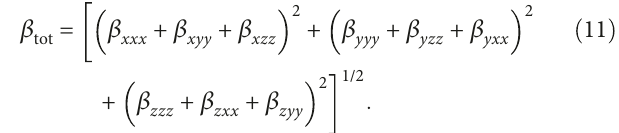
Table 7: Natural bond orbital analysis for the ground state (S0) and excited state (S1) of the dyes.